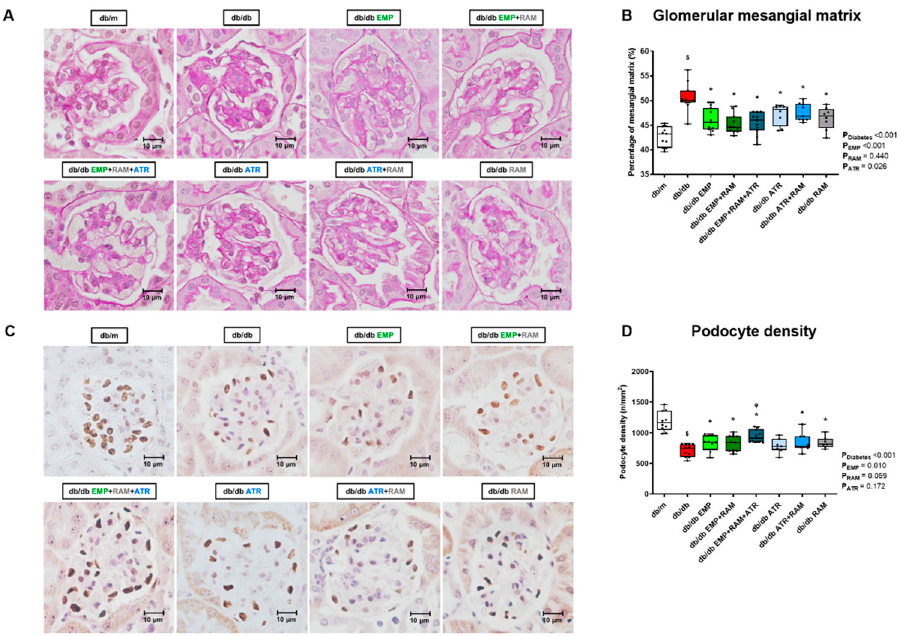
Figure 3. Glomerular mesangial matrix area and podocyte density in vehicle-treated db/m mice, vehicle-treated db/db mice, and db/db mice treated with empagliflozin, atrasentan, ramipril, or their combinations. ( A ) Representative PAS-stained glomerular microphotographs depicting glomerular mesangial matrix expansion (×400 magnification). ( B ) Percentage of glomerular mesangial matrix with respect to total glomerular tuft area. ( C ) Representative Wilms tumor 1 stained glomerular microphotographs showing podocyte density in each experimental group (×400 magnification). ( D ) Podocyte number per mm 2 of glomerular area. db/m : non-diabetic mice treated with vehicle. db/db : diabetic mice treated with vehicle. db/db EMP : diabetic mice treated with empagliflozin. db/db EMP + RAM : diabetic mice treated with empagliflozin and ramipril. db/db EMP + RAM + ATR : diabetic mice treated with empagliflozin, ramipril, and atrasentan. db/db ATR : diabetic mice treated with atrasentan. db/db ATR + RAM : diabetic mice treated with atrasentan and ramipril. db/db RAM : diabetic mice treated with ramipril. Factorial ANOVA main effect results are displayed next to the graph. P Diabetes : diabetes’ main effect. P EMP : empagliflozin’s main effect. P RAM : ramipril’s